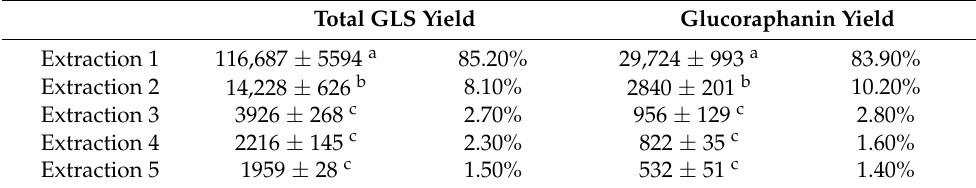
Table 4. Extraction yield of total glucosinolates and glucoraphanin from broccoli sprouts. Total GLS Yield Glucoraphanin Yield Extraction